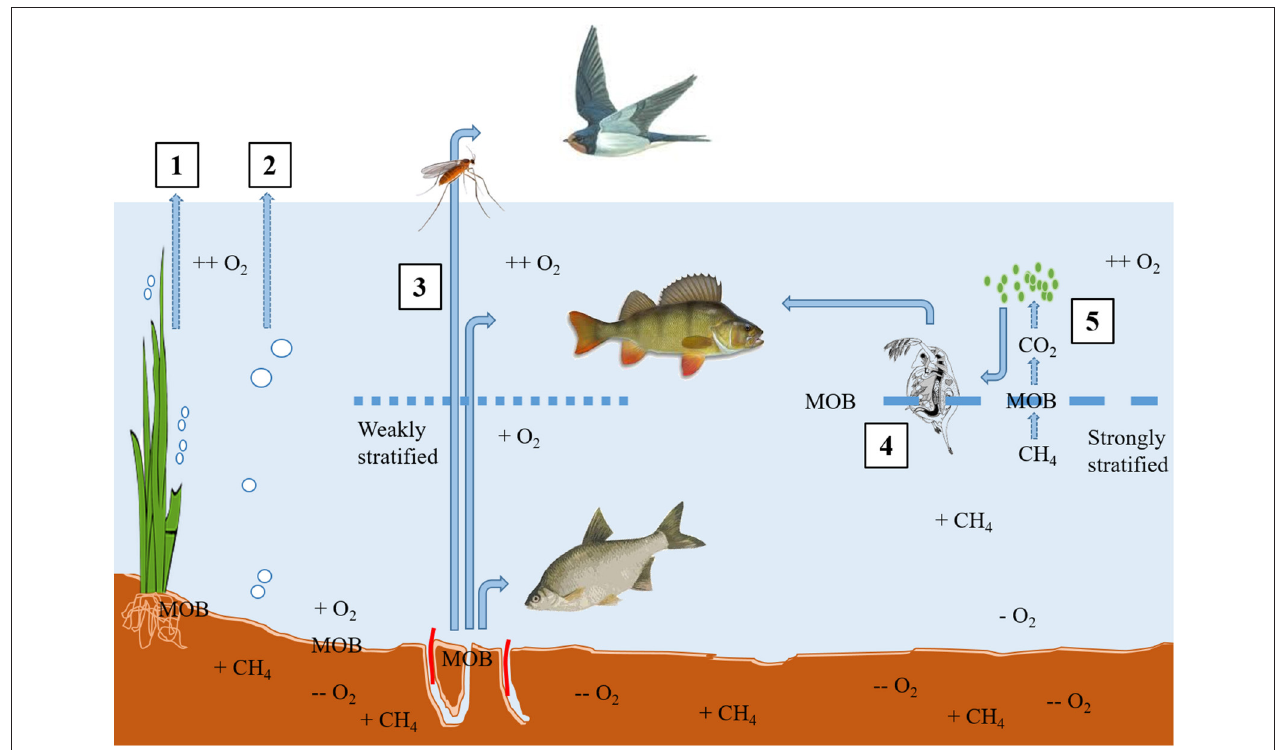
FIGURE 1 | Methane produced in anoxic sediments may be routed through plants (1) or lost from the sediments to the atmosphere via ebullition or micro-bubbles (2). If it reaches a boundary with oxygen at the sediment-water interface (under mixed or weakly stratified conditions), MOB oxidize it and create biomass which routes via benthic macroinvertebrates into benthic, pelagic, and terrestrial predators (3) . Under strongly or permanently stratified conditions, methane will diffuse upwards through the water-column, and oxygen (and MOB) might first be encountered at the metalimnion, where zooplankton link MDC into higher predators (4) . An indirect route for MDC could be via CO 2 derived from the oxidation of CH 4 might then be cycled through phytoplankton, and hence on to zooplankton (5) , or indeed via sedimentation back down to benthic